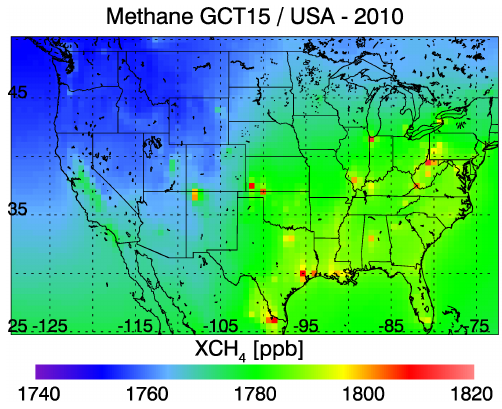
Figure 8. Annually averaged (year 2010) atmospheric column- averaged methane ( X CH 4 ) computed with GEOS-Chem using a posteriori methane emissions of Turner et al. (2015) (“GCT15 data set”). The resolution of this data set is 0.5 ◦ latitude × 0.667 ◦ longi- tude.